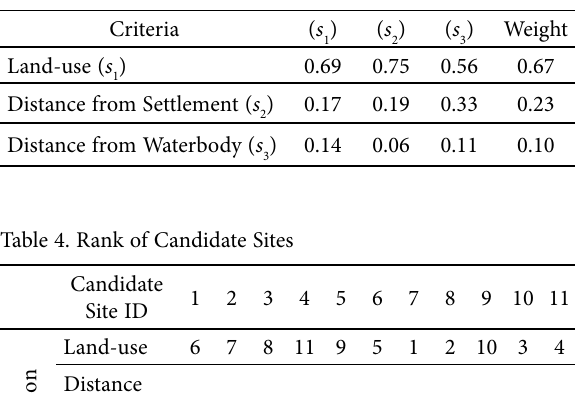
Table 3(b). Normalized matrix and significant weight of each criteria for candidate site ranking criteria